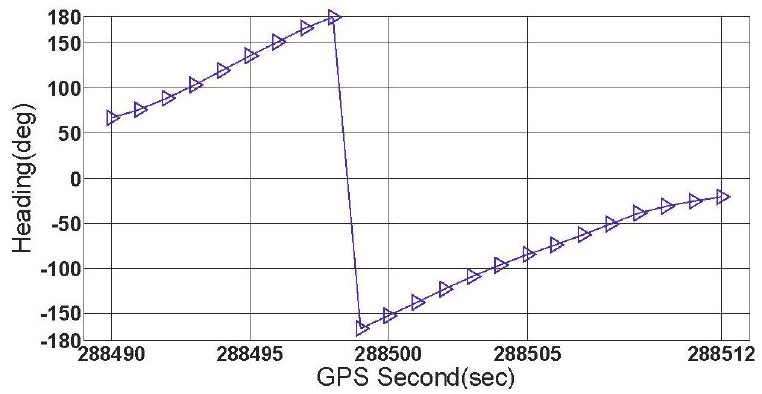
Figure 10. Vehicle orientations for data section F.